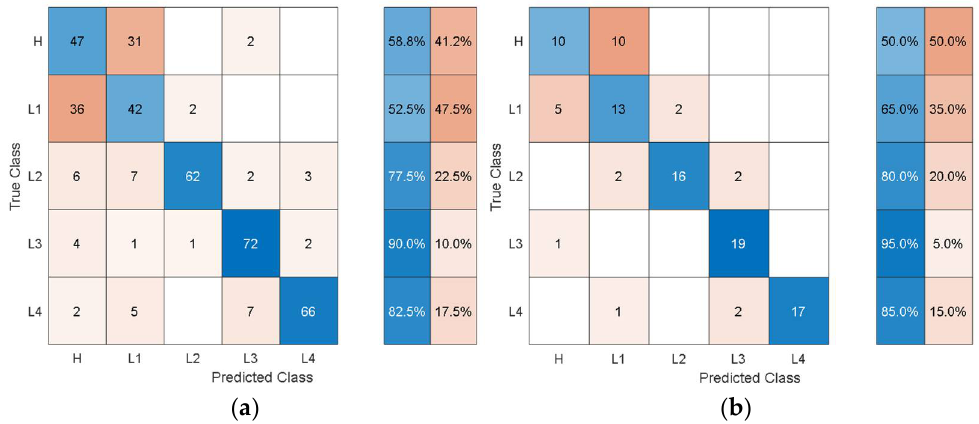
Figure 10. Classification performance of SVM using the autonomous features from the 142nd layer of GoogleNet in terms of its confusion matrices: ( a ) training; ( b ) test.